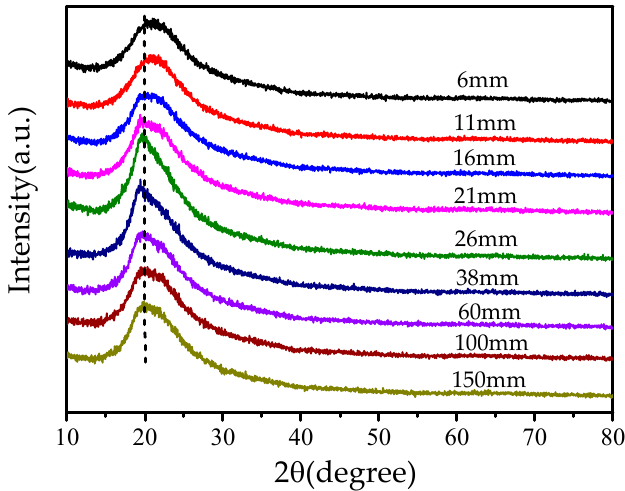
Figure 4. X-ray diffraction (XRD) spectra of PVA nanofiber membranes prepared by different needles.